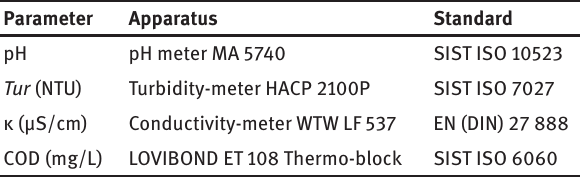
Table 1: Standard methods.